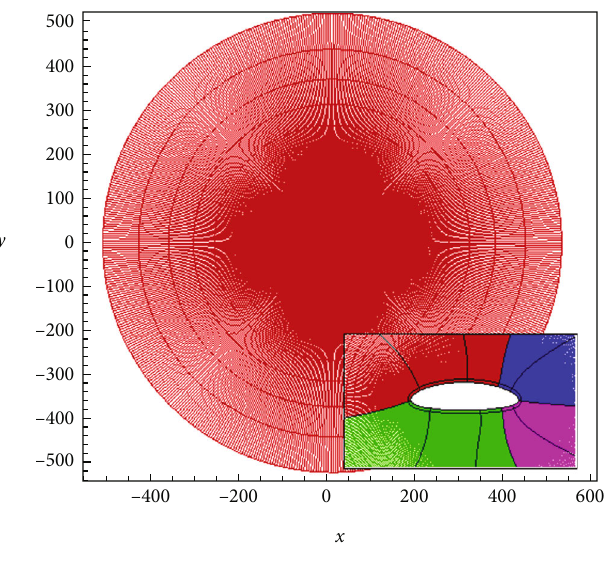
Figure 4: Structural grid. Table 2: Grid information ( Re = 1 : 4 × 10 6 ).